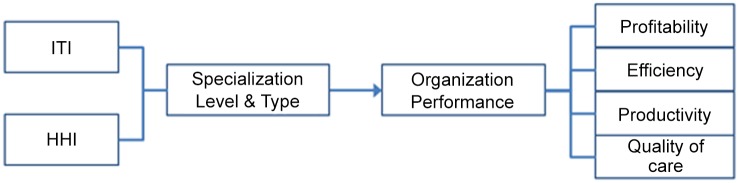
Research Framework.